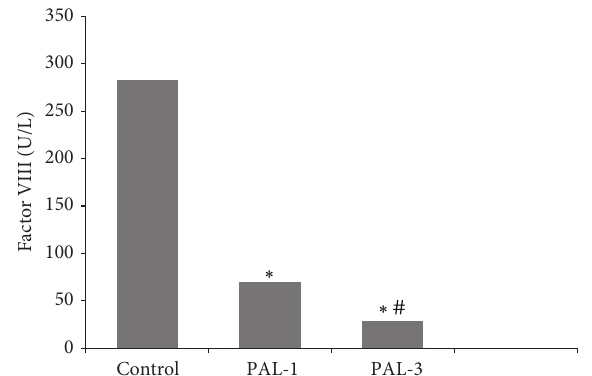
Figure 1: Factor VIII levels in control, PAL-1, and PAL-3 groups. PAL-1 group: receiving paliperidone 1mg/kg for ten days; PAL-3 group:receivingpaliperidone3 mg/kgfortendays. ∗ 𝑃 < 0.05 versus control group. # 𝑃 < 0.05 versus PAL-1 group.